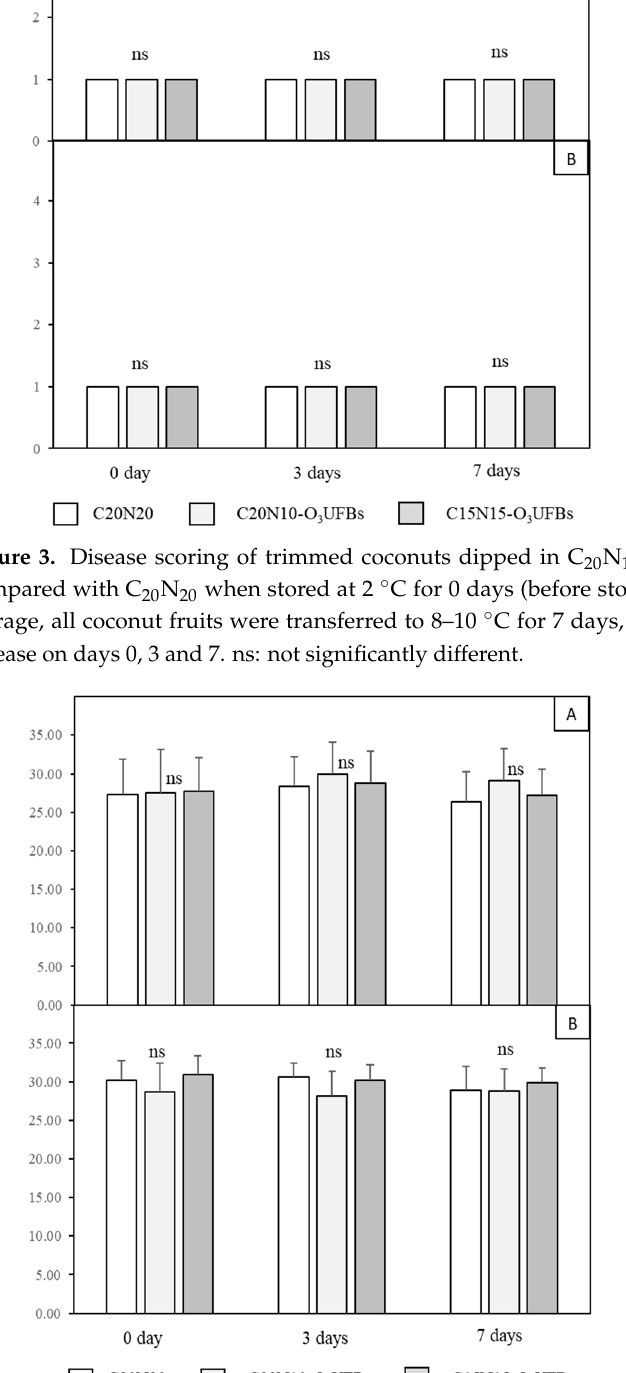
Figure 5. Mesocarp browning index of trimmed coconuts dipped in C 20 N 10 -O 3 UFBs and C 15 N 15 - O 3 UFBs compared with C 20 N 20 when stored at 2 °C for 0 days (before storage) ( A ) and 30 days ( B ). After storage, all coconut fruits were transferred to 8–10 °C for 7 days, and the browning index was evaluated on days 0, 3, and 7. ns: not significantly different.